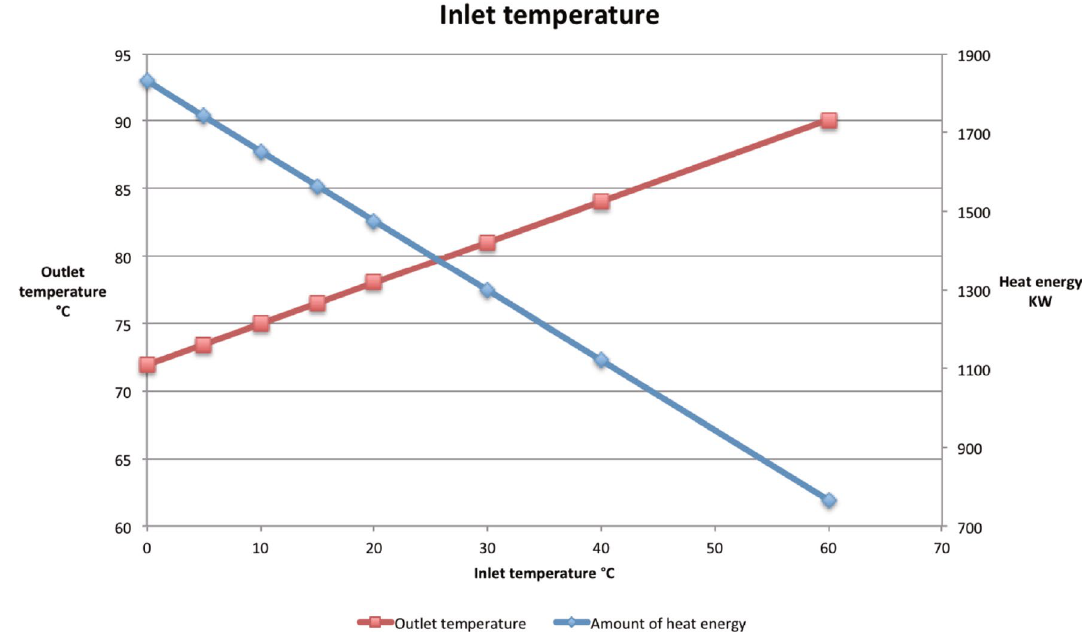
Fig. 6 Temperature and heat energy regarding working fluids’ inlet